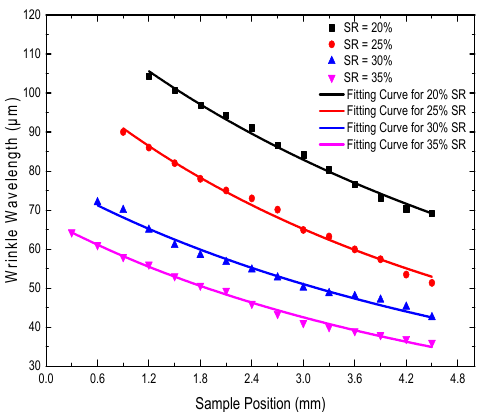
Figure 7. Continuously changing wrinkle wavelengths obtained at different SR are schematically depicted as a function of the sample position. The solid lines correspond to the fits according to Equations (3) and (4).